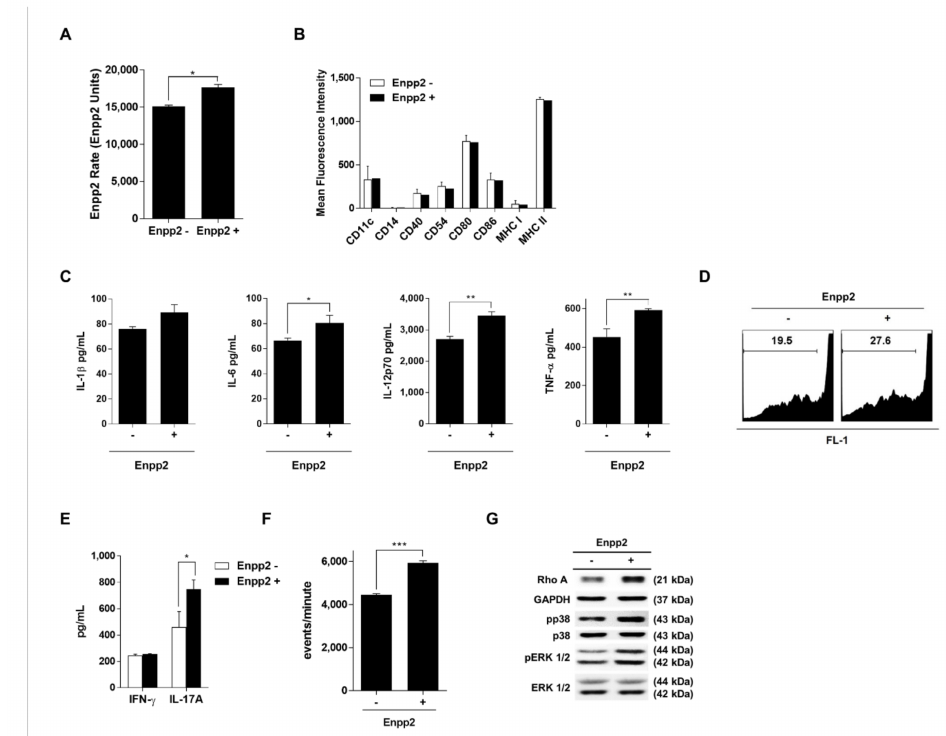
Figure 3. Enpp2 increases the immunogenicity of mDCs. ( A ) Fluorescence assay of Enpp2 activity. Enzyme activity in conditioned medium was measured over 2 h. The bar graph shows the Enpp2 activity rates, expressed as the mean ± SEM ( n = 3 independent DC preparations). ( B ) DC subsets (mDC; Enpp2- and recombinant Enpp2 protein treated mDCs; Enpp2+) were stained with the indicated fluorescent-labeled antibodies and analyzed by flow cytometry. The bar graphs show the MFI, expressed as the mean ± SEM ( n = 3 independent DC preparations). ( C ) Pro-inflammatory cytokines in culture supernatants from DCs were analyzed by ELISA. Data are expressed as the mean ± SEM ( n = 3 independent DC preparations) of duplicate experiments. ( D ) Each DC subset was co-cultured for 72 h with CFSE-labeled CD3 + T-cells to measure T-cell proliferation. ( E ) Cytokine levels in the supernatants after 72 h of co-culture were measured by ELISA. Data are expressed as mean ± SEM ( n = 3 independent co-culture preparations) of duplicate experiments. ( F ) Migration assay. The number of migrating DCs harvested from the lower Transwell chamber was counted by flow cytometry. The bar graph shows the events/minute, expressed as the mean ± SEM ( n = 3 independent DC preparations). ( G ) Western blot analysis of RhoA, p38, Erk1/2 expression. Data are representative of three independent experiments. * p < 0.05, ** p < 0.01,